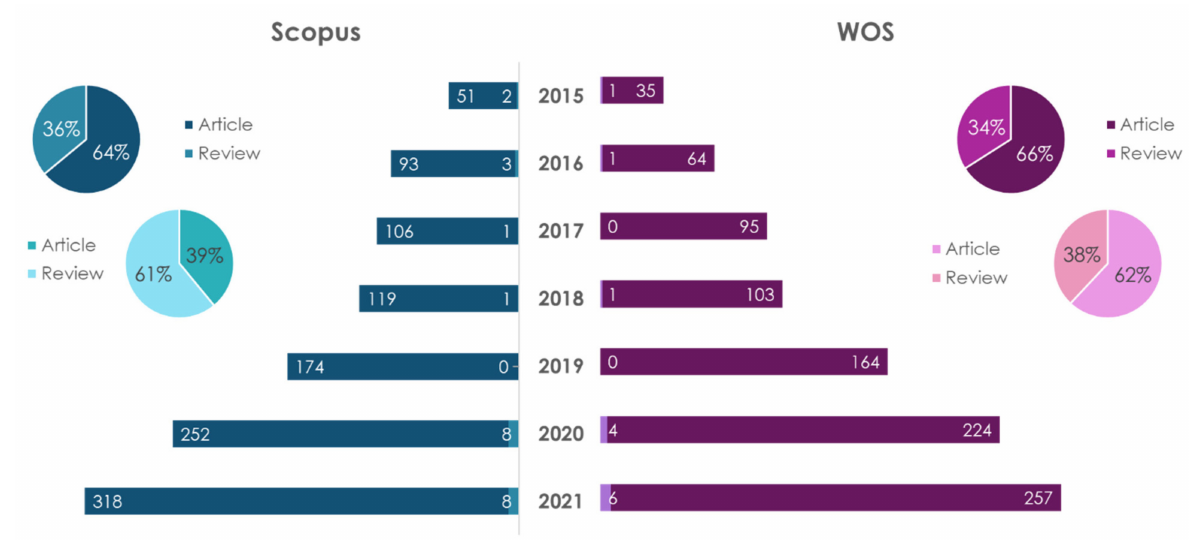
Figure 3. Statistical results of the search in the Scopus/WOS databases for the keywords “personalized nutrition” (dark color) and “personalized nutrition and atherosclerosis” (light color).